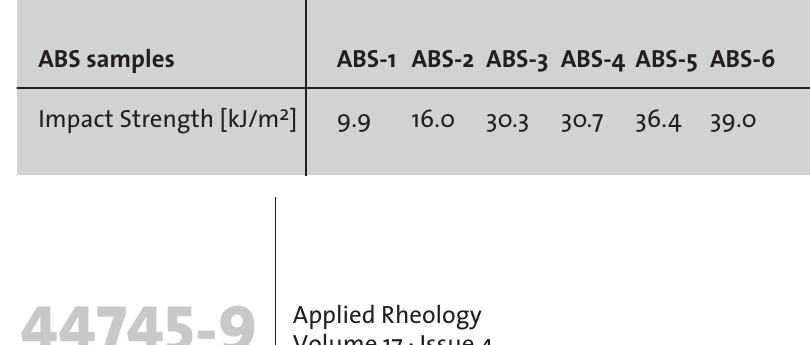
Table 2: Impact strength values of ABS